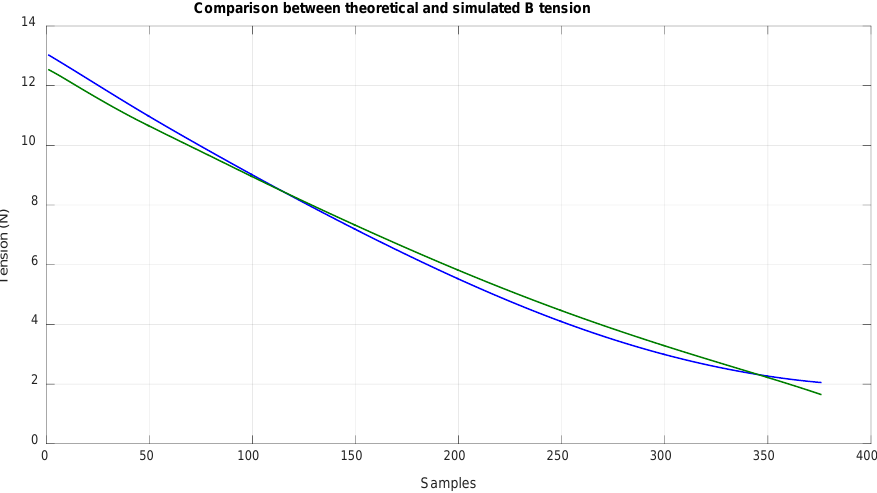
Figure 14. Comparison of the theoretical tension of B cable (blue) and the simulated tension of B cable (green).